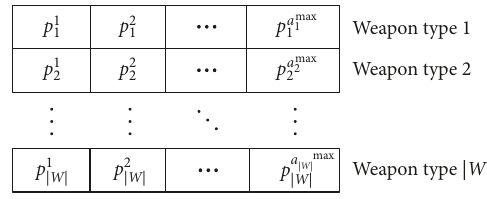
Figure 6: Chromosome representation of priority